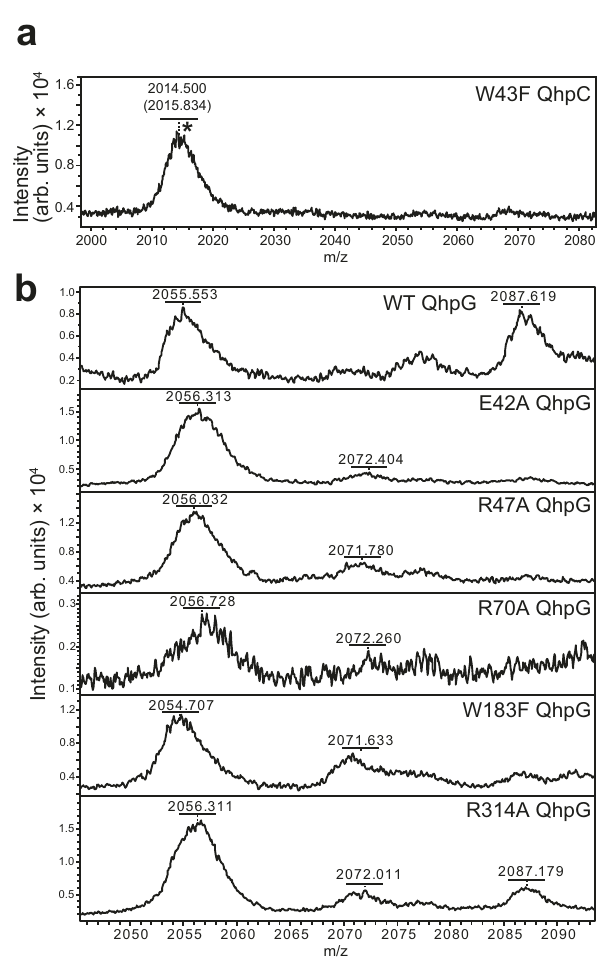
Fig. 5 MALDI-TOF MS analysis of QhpG-catalyzed reaction products. a The reaction product with the W43F mutant of crosslinked QhpC as the substrate for QhpG (*fragment d of Asp-N digestion). The calculated mass ( m/z ) is indicated within parentheses. b The reaction product formed by the wild-type (WT) and various mutants (E42A, R47A, R70A, W183F, and R314A) of QhpG (fragment d of Asp-N